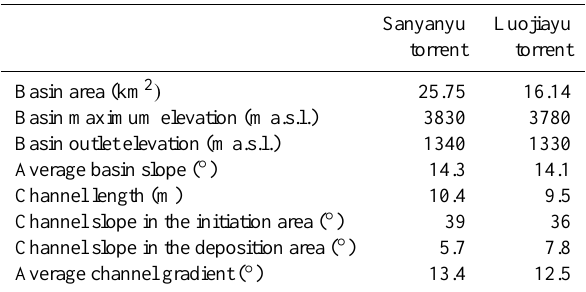
Table 1. Main morphometric parameters of Sanyanyu and Luojiayu basin and